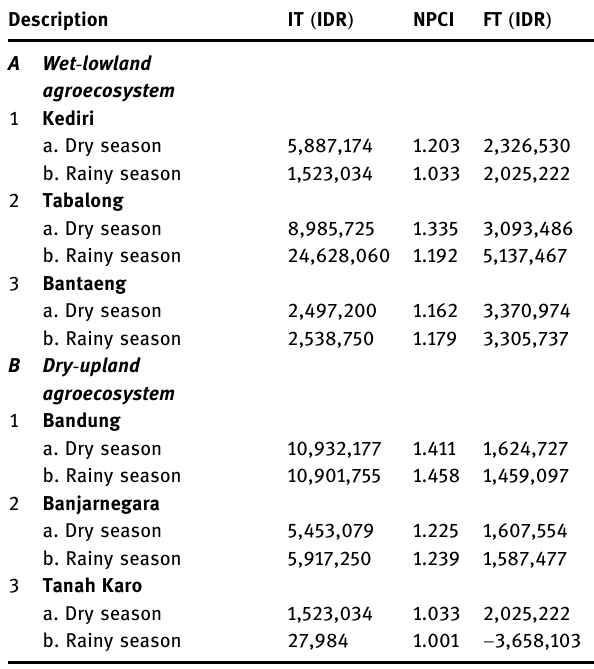
Table 5: IT, NPCI, and FT values of chili farming in